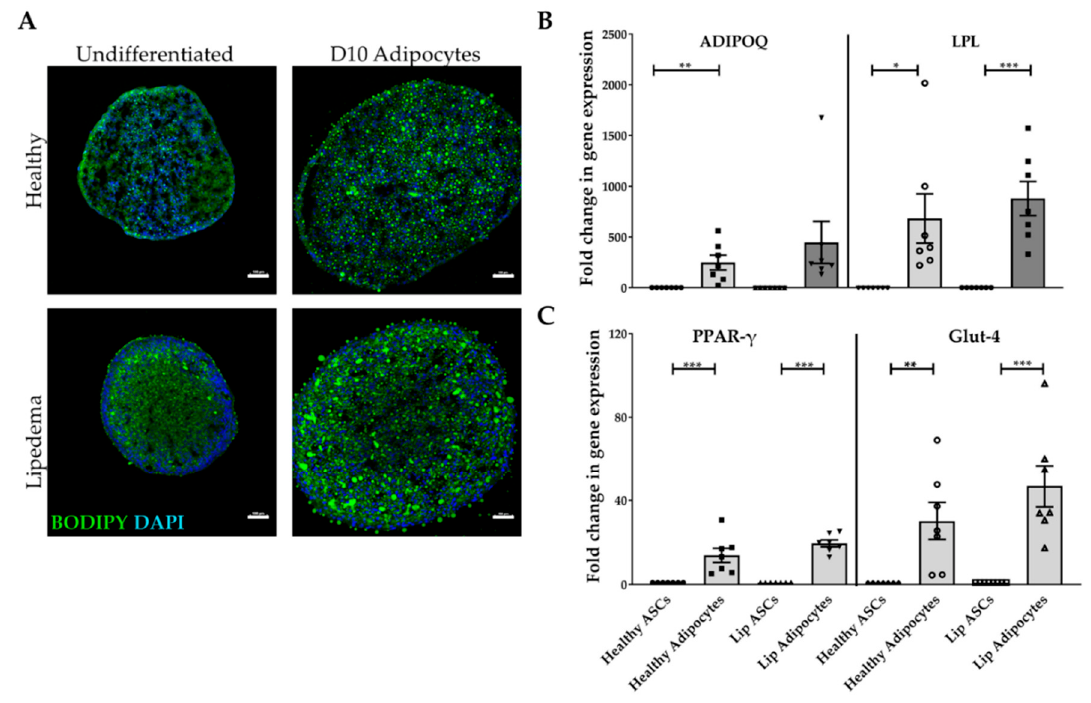
Figure 2. In vitro adipogenic di ff erentiation of ASC spheroids. ( A ) BODIPY staining (green) showing lipid accumulation in di ff erentiated adipocytes (scale bar, 100 µ m). Nuclei were stained with DAPI (blue). ( B , C ) qRT-PCR showing the expression of ADIPOQ, LPL ( B ), PPAR- γ , Glut4 ( C ) in ASCs and adipocytes ( n = 7 per group). qRT-PCR analysis showed a significant increase in gene expression in di ff erentiated adipocytes. The values are the mean ± SEM. * p < 0.05; ** p < 0.01; *** p < 0.001.